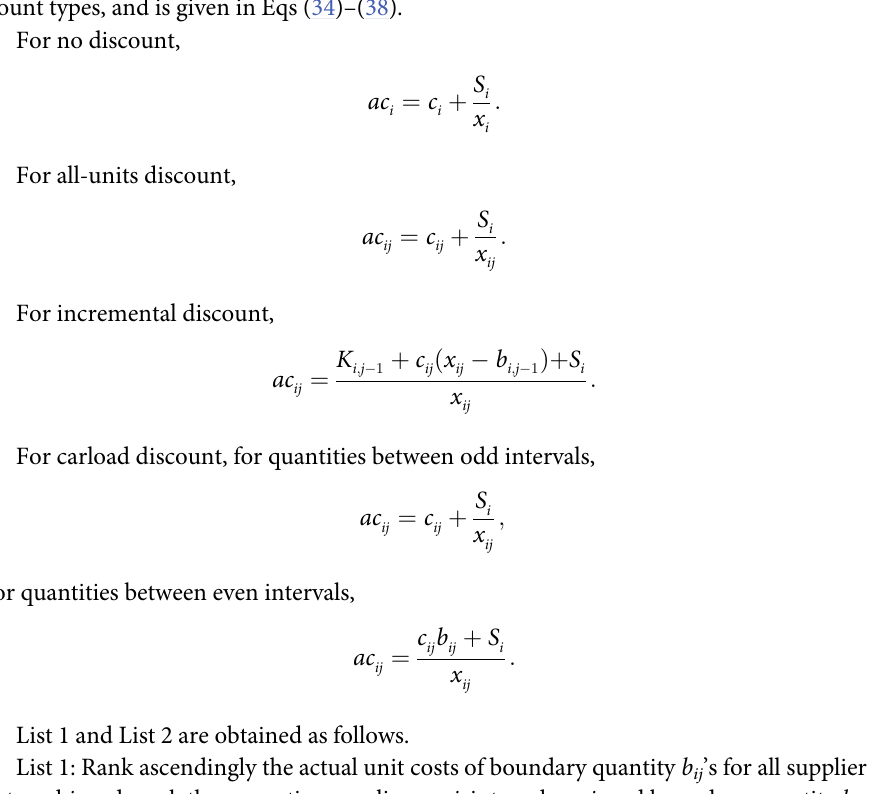
Algorithm SGDQD: Simple greedy algorithm for supplier selection